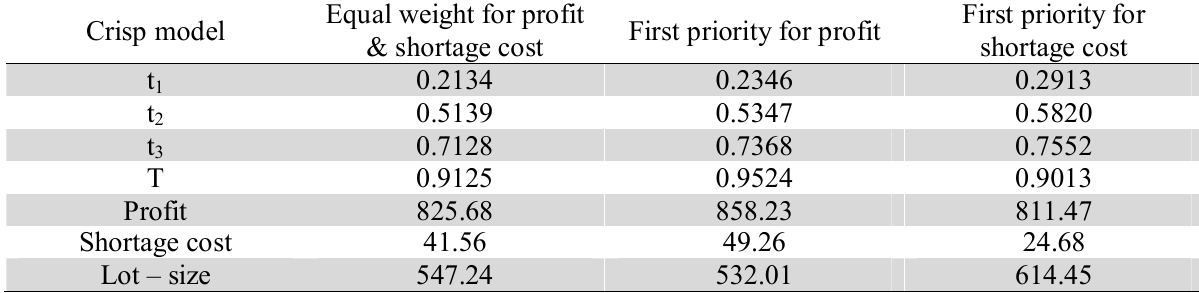
Results for Fuzzy